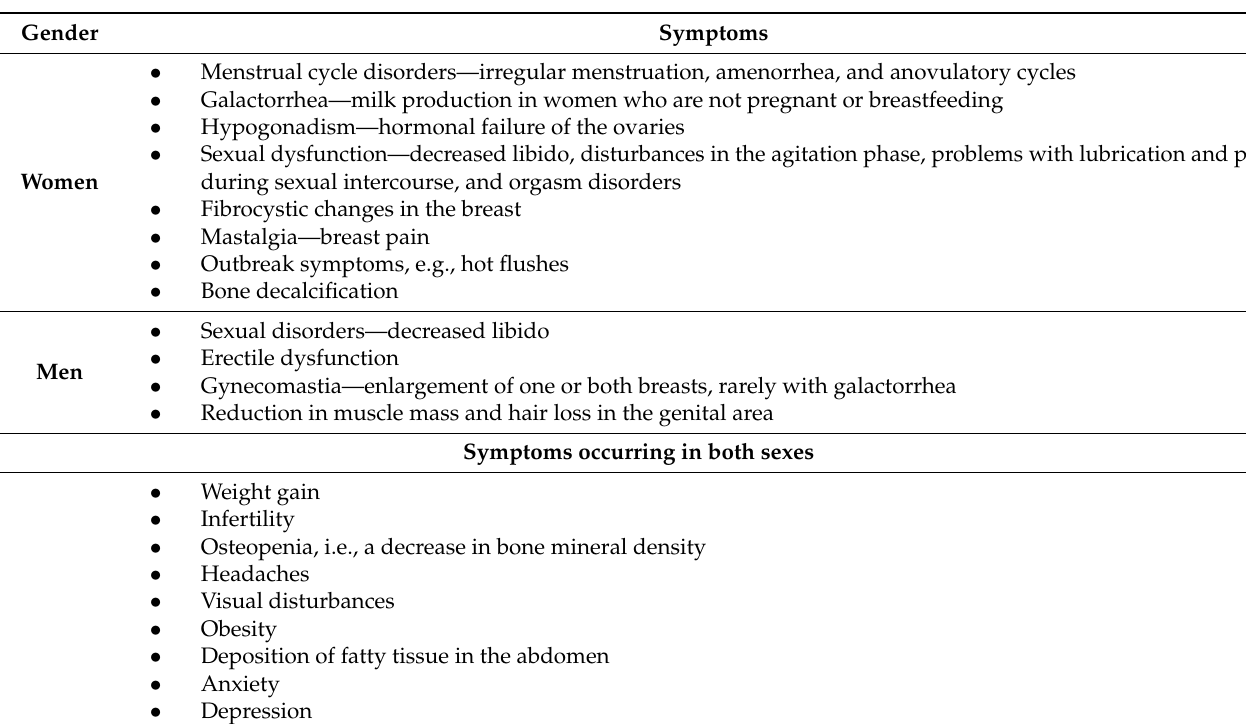
Table 1. The symptoms of hyperprolactinemia distinguished by